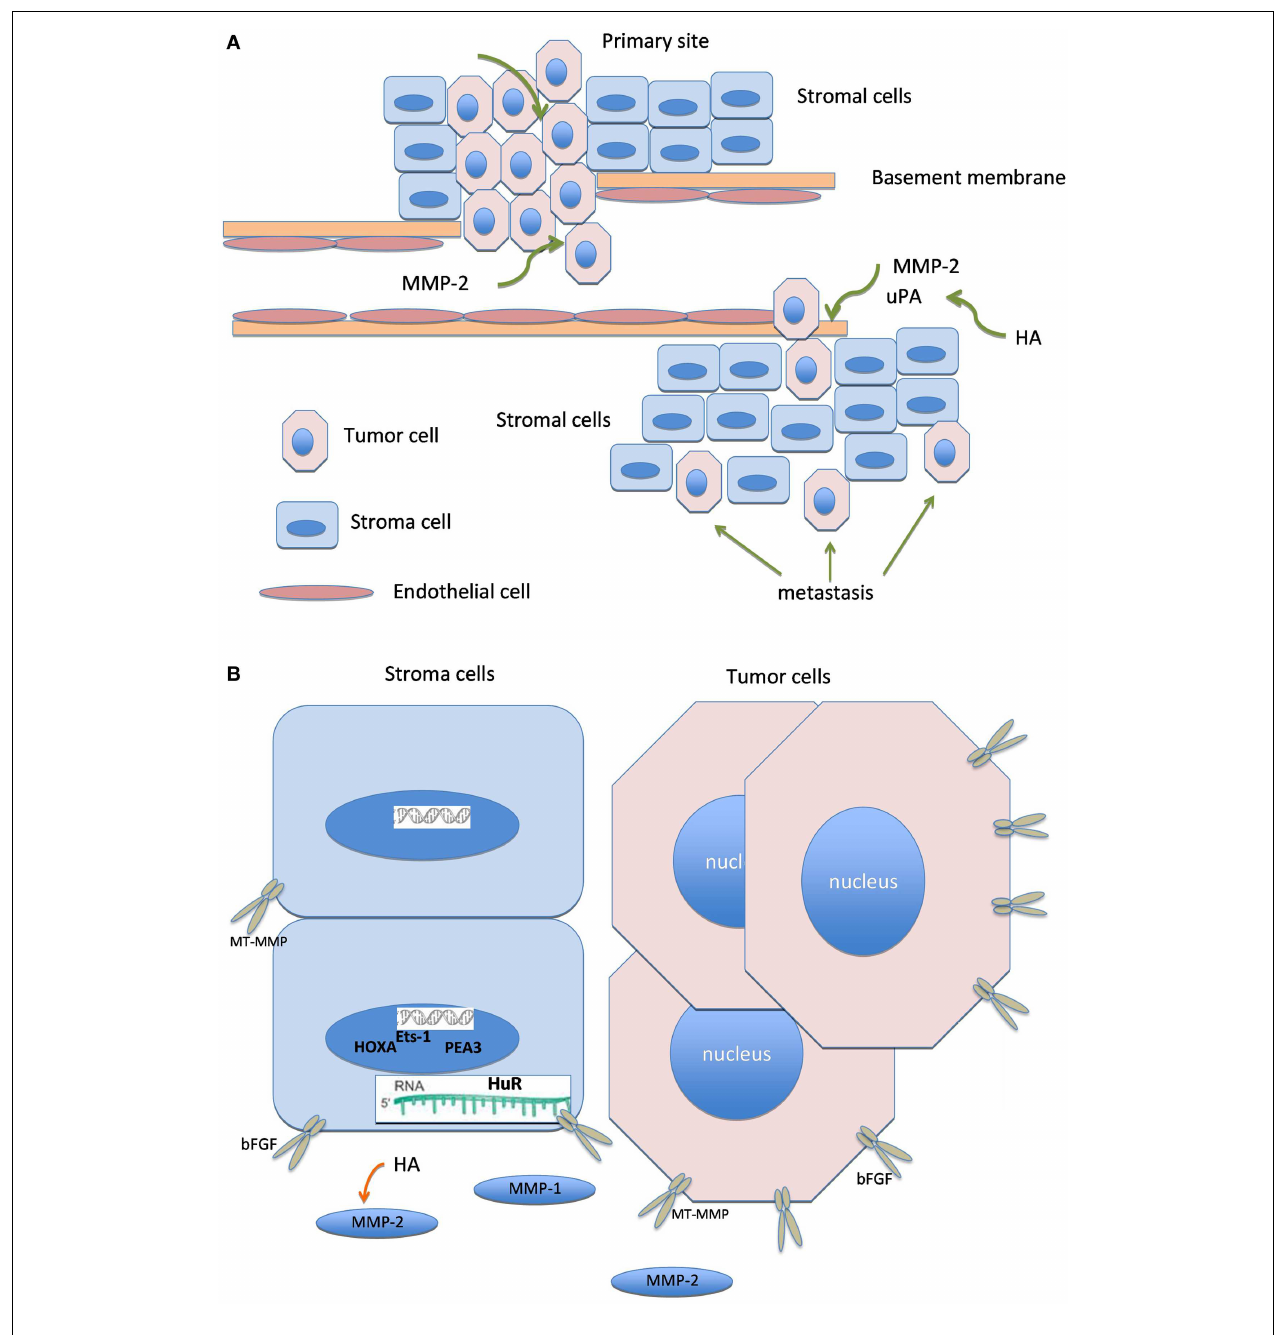
hyaluronic acid (HA), basic fibroblast growth factor (bFGF), matrix metalloproteinases (MMP), urinary-type plasminogen activator, ETS transcription factors, HuR, and